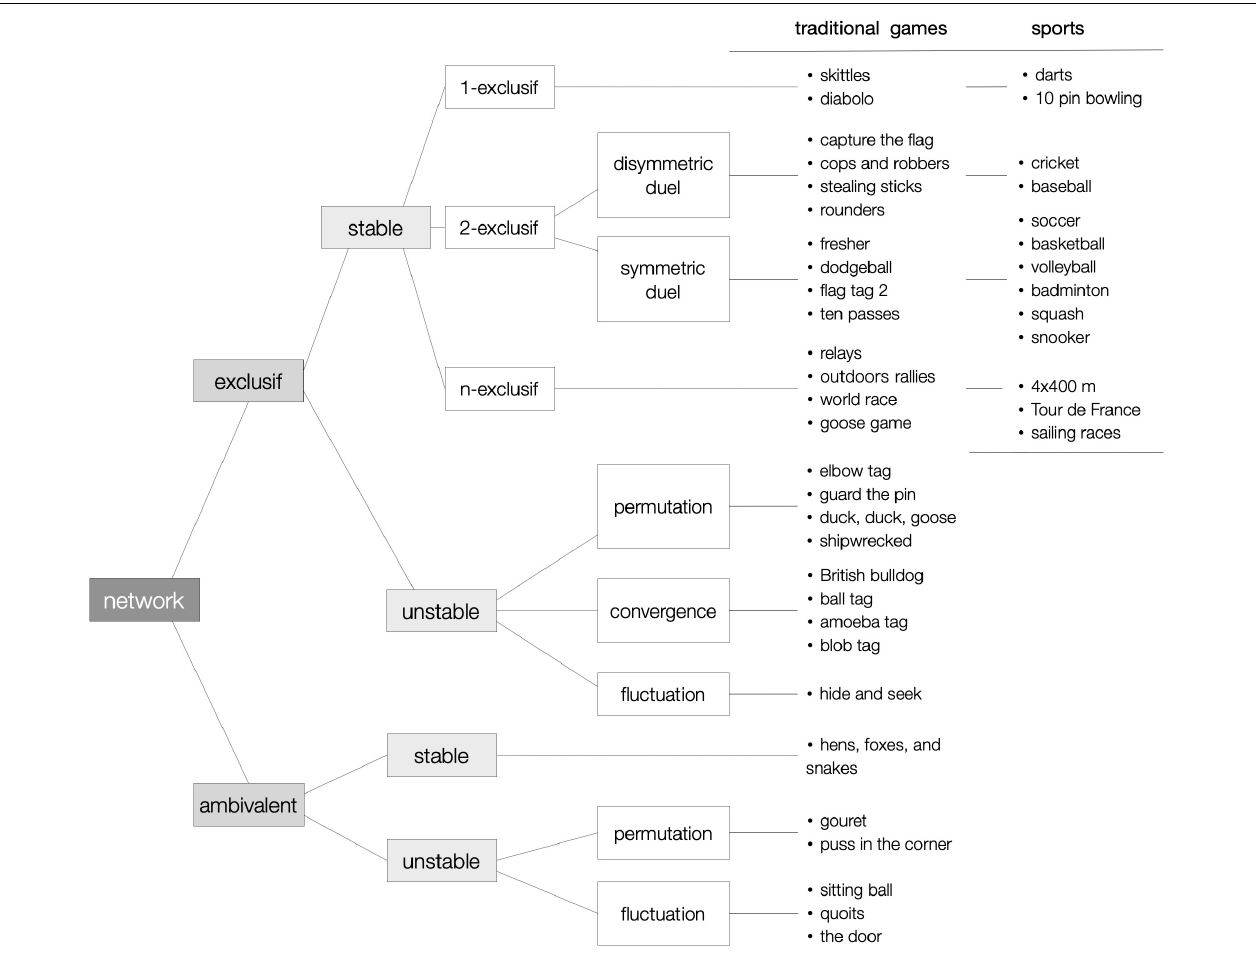
FIGURE 2 | Networks of motor communications: comparison between sports and traditional games (modified from Parlebas, 1986, p.